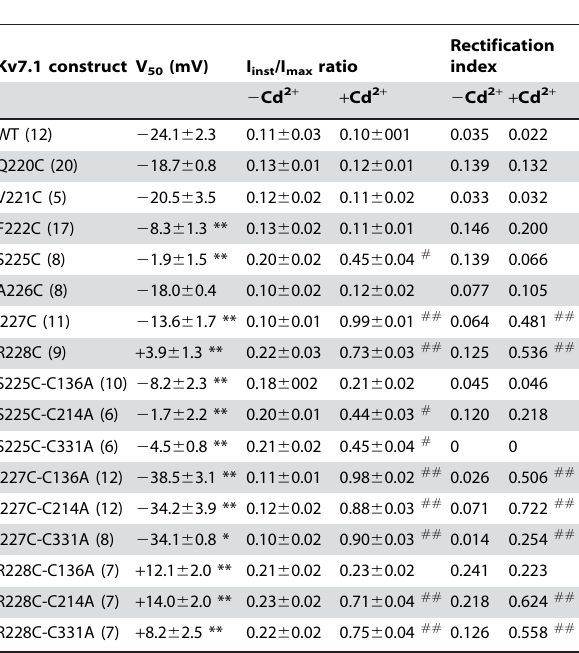
Table 1. Electrophysiological parameters of WT and